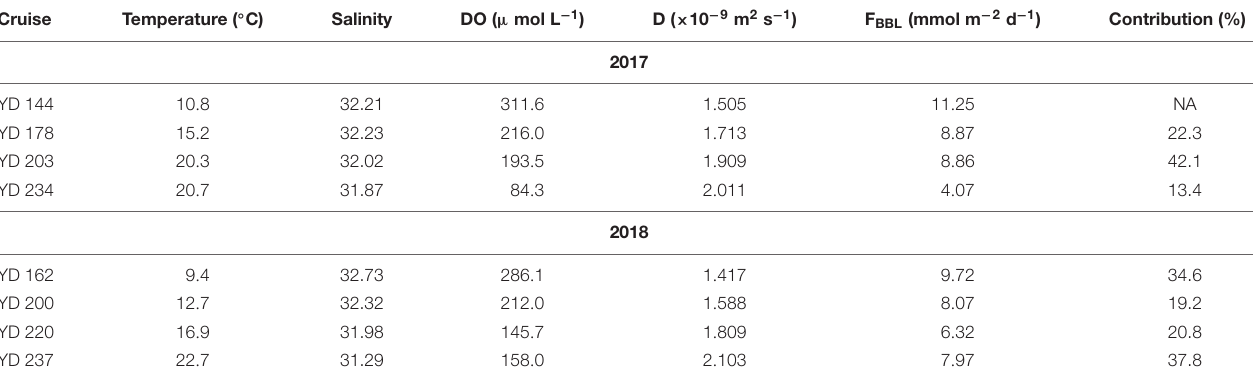
TABLE 5 | Estimated DO fluxes through the bottom boundary layer (F BBL ) and their contributions to the net oxygen consumption rate in bottom water at station A5, along with other parameters in the bottom